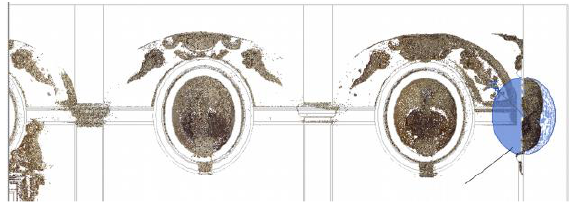
Figure 12. Creation of niche by subtraction